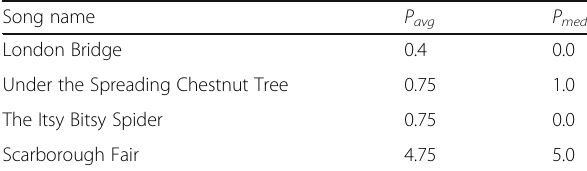
Table 1 Results of average and median in each song Song